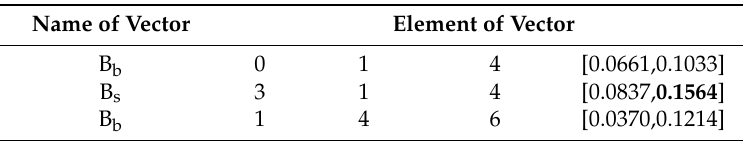
Table 9. Identification template 2 for water